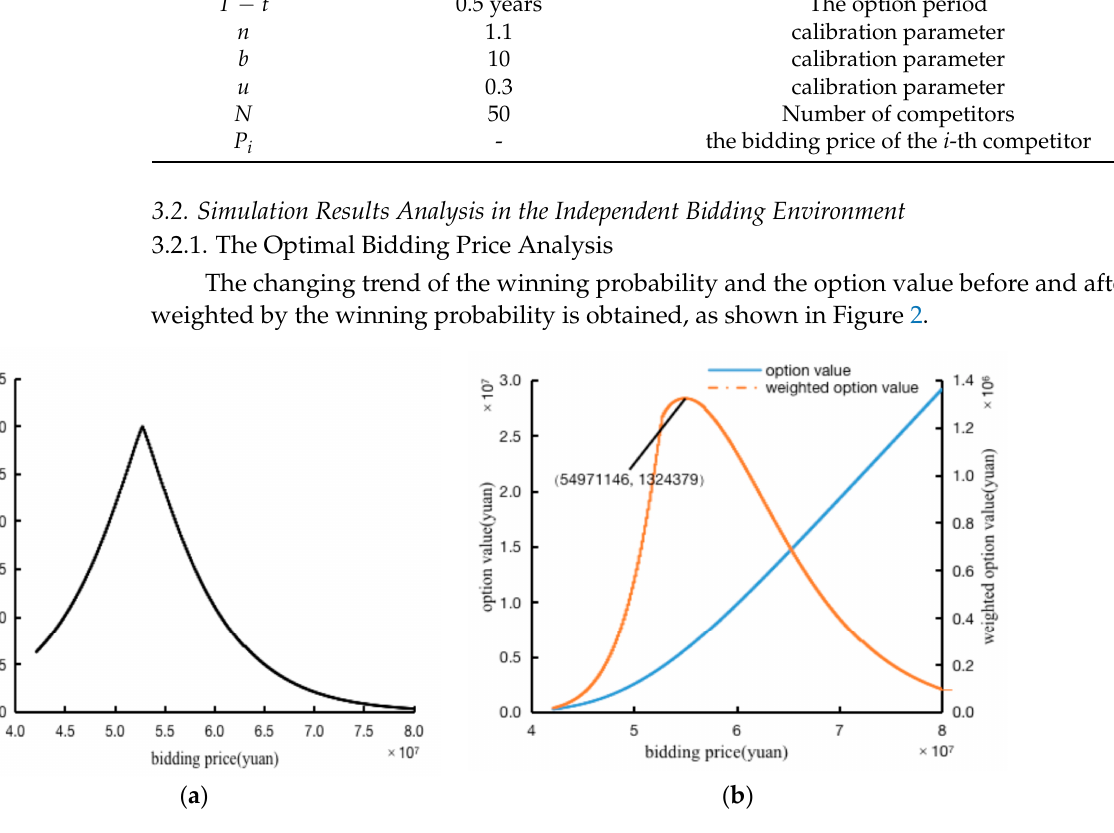
Figure 2. Optimal decision determination of bidding price. ( a ) Fluctuation trend of winning probability; ( b ) Fluctuation trend of option value and weighted option value.